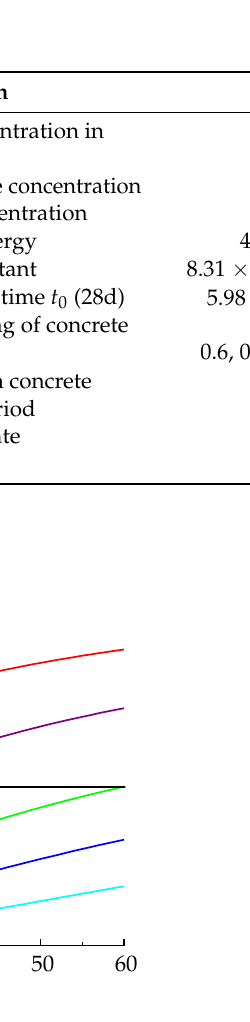
Figure 3. Relation between chloride content ( C ) at the steel surface and exposure time ( t ).